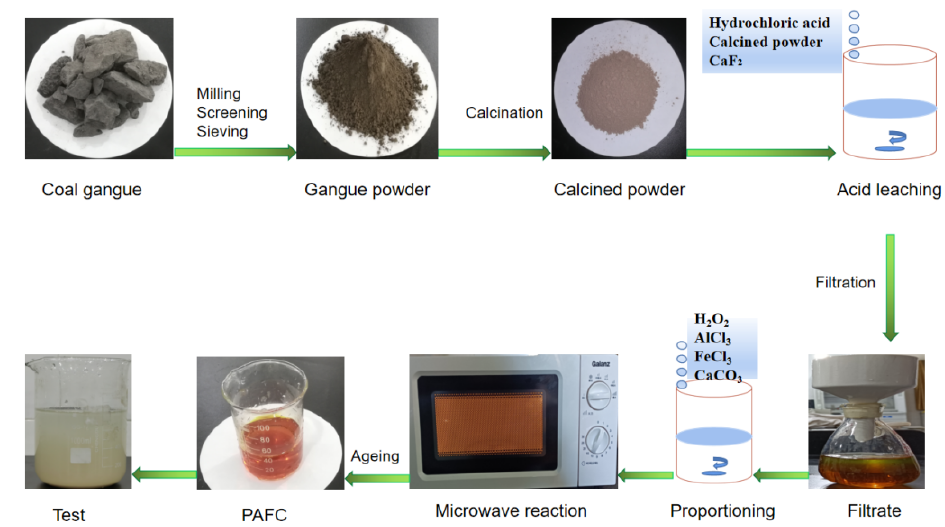
Figure 1. Flow chart of the experiments.